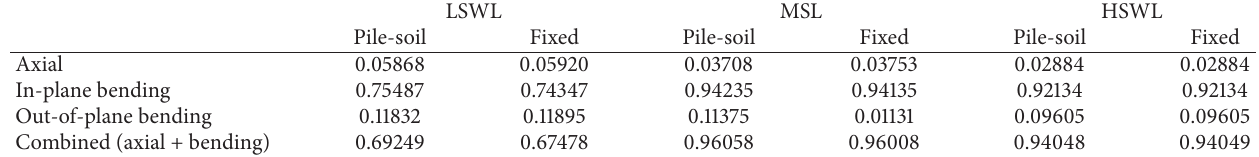
Table 17: Joint unity checks for regular wave.